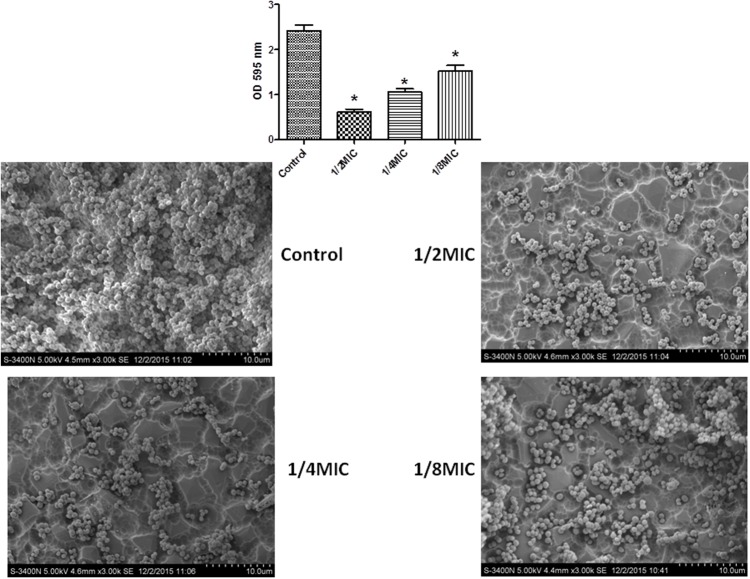
Effect of sub-MICs of cefquinome on biofilm formation by Staphylococcus xylosus ATCC700404. The results of the crystal violet staining and scanning electron microscopy (SEM) (Images of the electron microscope) were found at the concentration of each cefquinome concentration. Data are expressed as means ± SDs. Controls refer to the absence of cefquinome. Significantly different (∗∗p < 0.01, ∗p < 0.05) compared to untreated control bacteria.